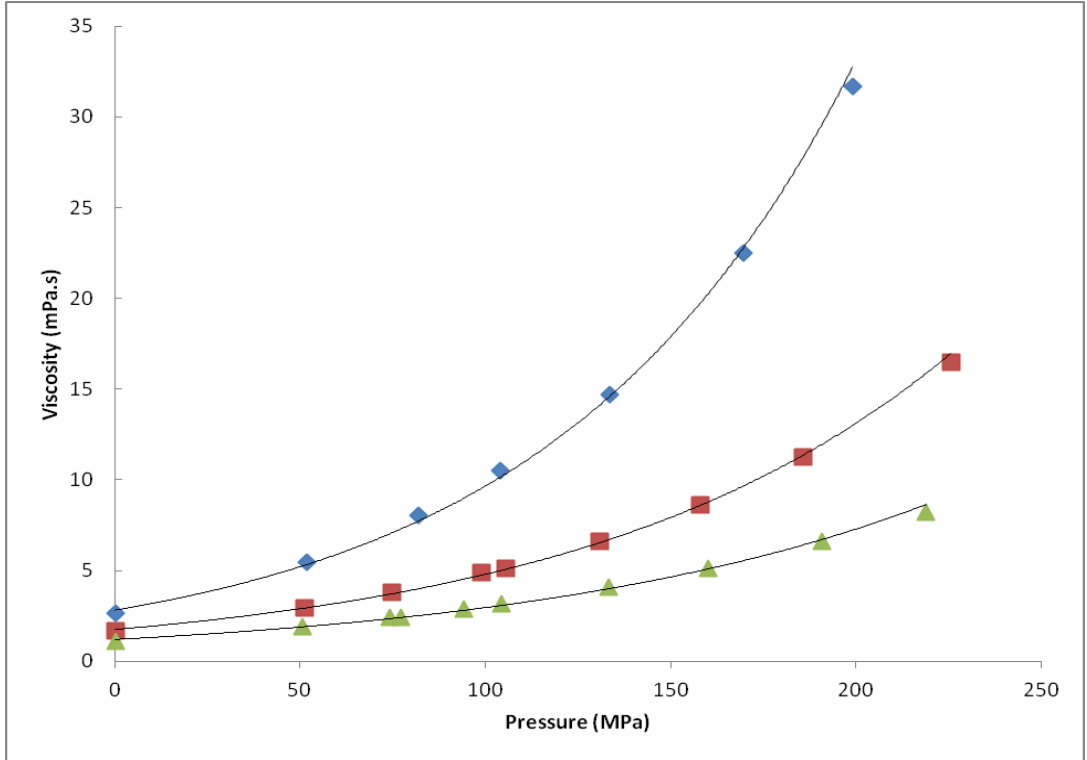
Figure 6. Variation of viscosity for Fuel 3 with temperature. ♦ 298 K, ■ 323 K, and ▲ 348 K.